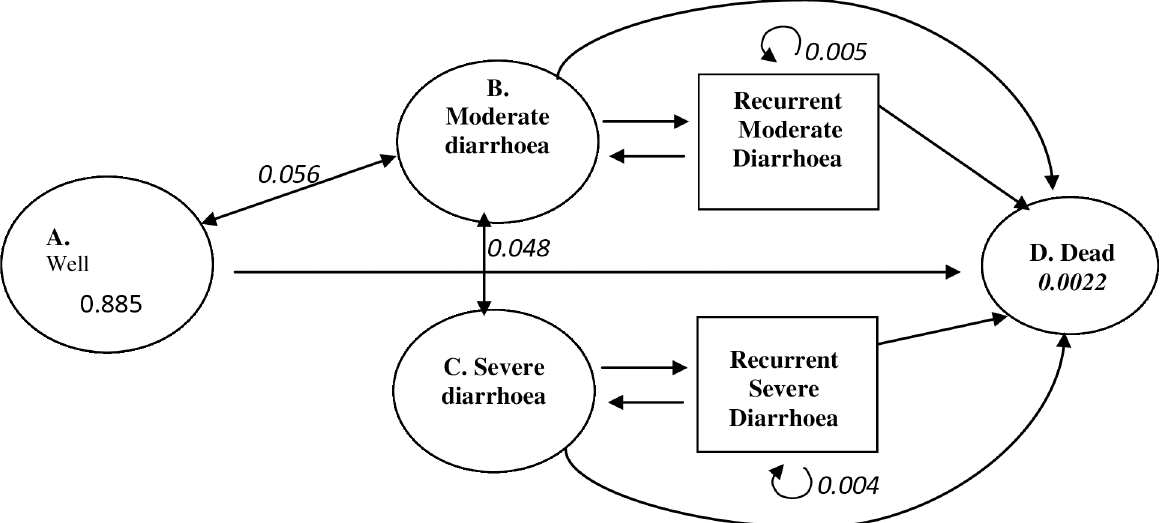
Fig 1. Model figure showing the transition to different health states and their probabilities.